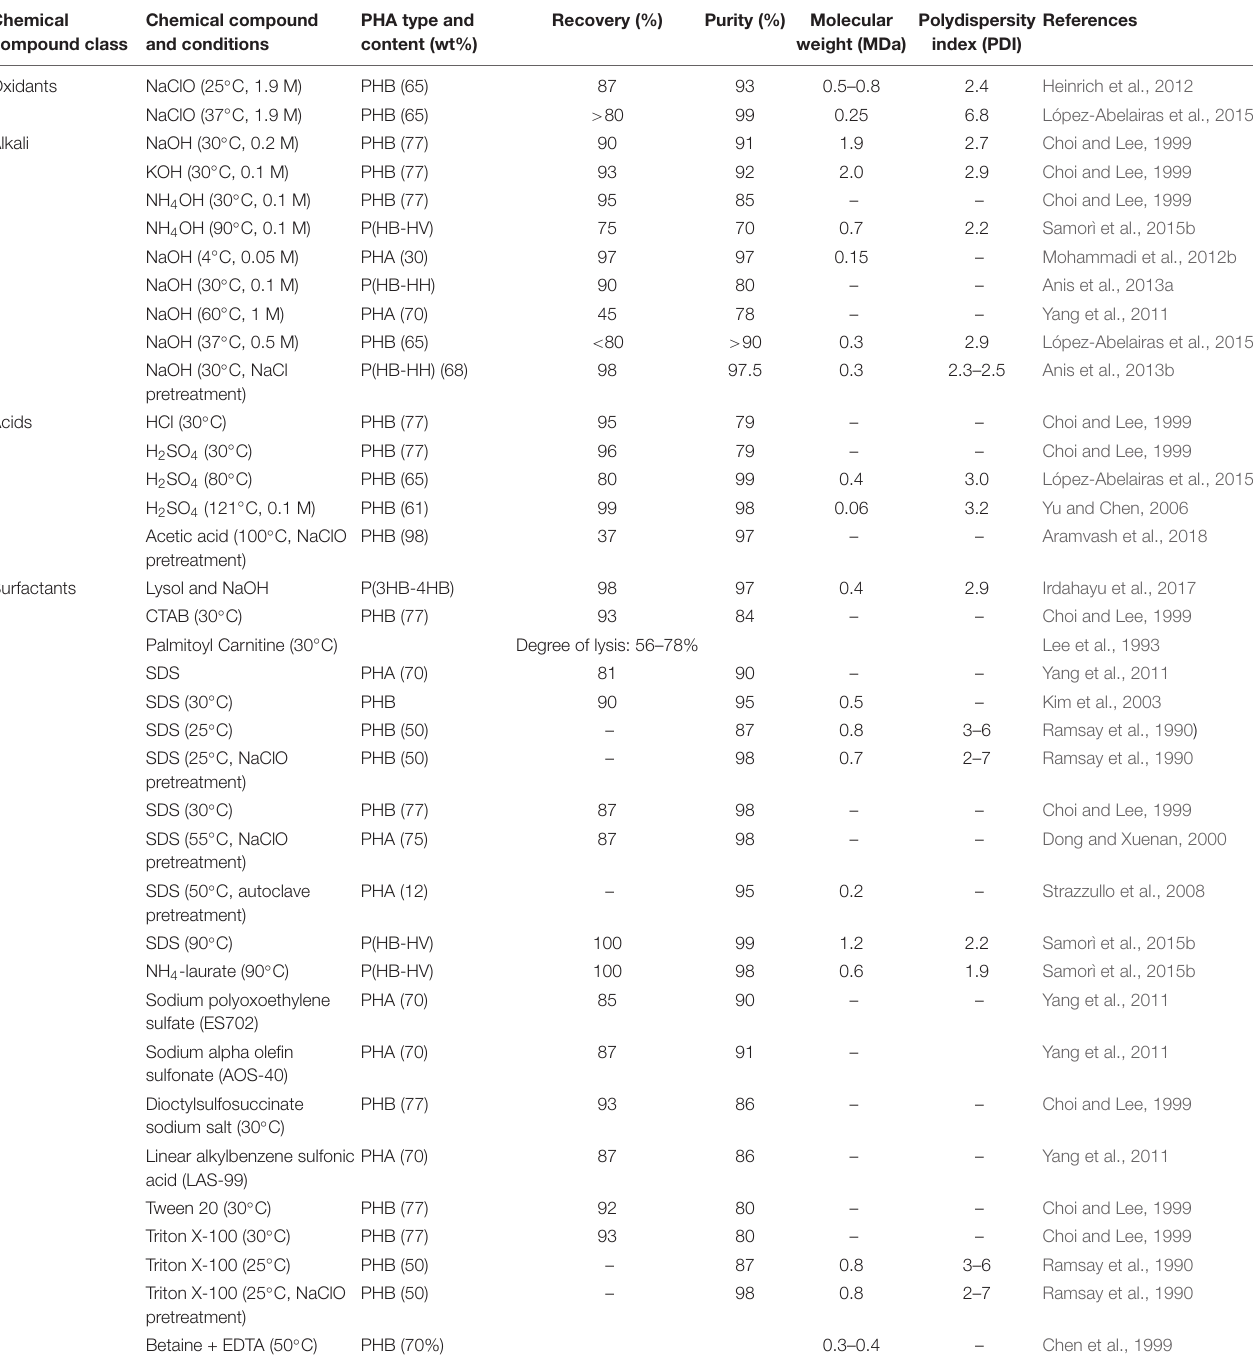
TABLE 2 | PHAs extraction from single strains through cellular lysis assisted by chemicals. Chemical Chemical compound compound class and